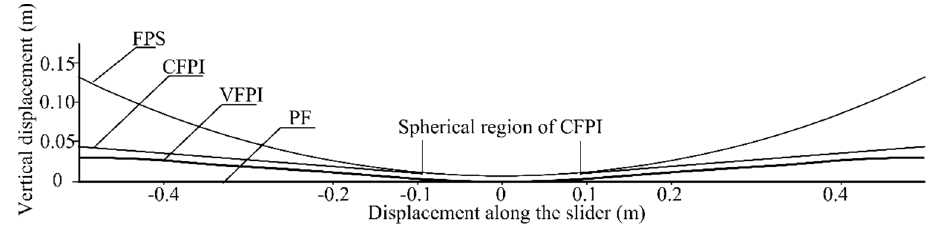
Figure 3. Comparison of various sliding isolation system geometries [10].